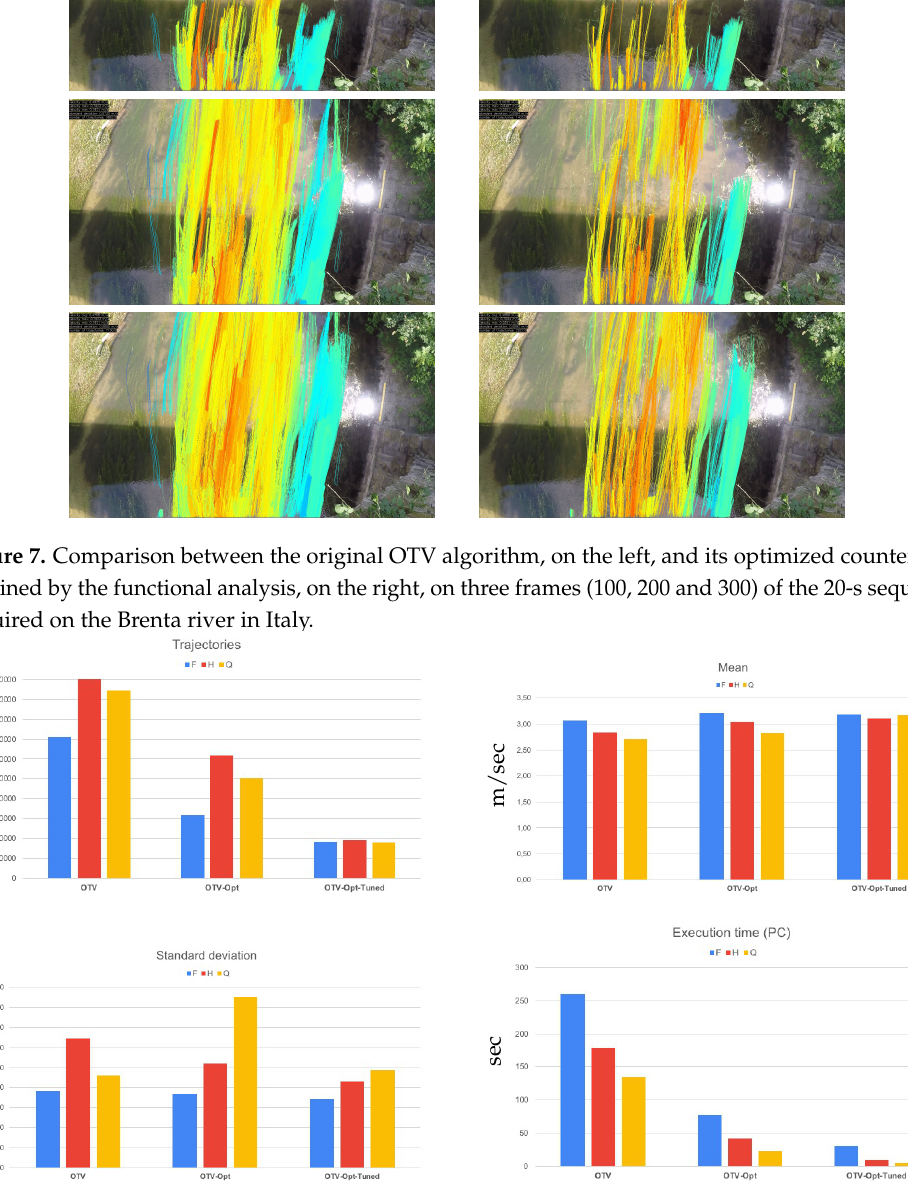
Figure 8. Comparison between the original OTV algorithm and its optimized counterpart obtained by the functional analysis at three resolutions on a sequence acquired on the Tevere river. For the optimized version, we report the outcome using the same optimal parameters found for the Brenta video (OTV-Opt) and optimal parameters found for the Tevere river (OTV-Opt-Tuned). ( Top-left ) Estimated trajectories, ( Top-Right ) average velocity, ( Bottom-Left ) standard deviation of velocity, ( Bottom-Right ) overall execution time on a standard PC (Intel 7700K at 4.2 GHz) without additional